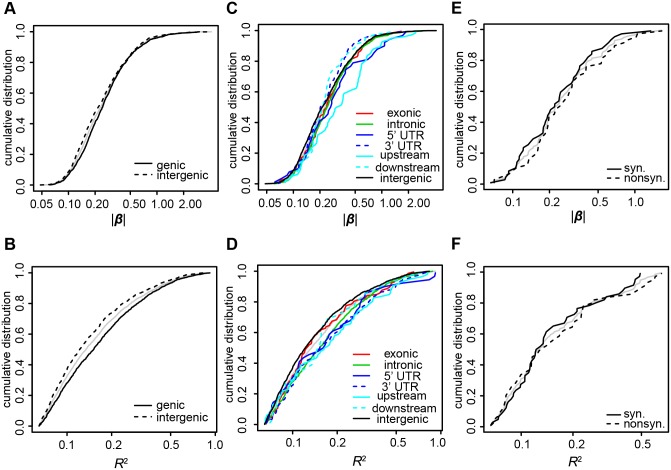
Cumulative curves of effect magnitudes of cis-eQTLs in gene-structure-based functional categories.Cumulative curves represent the distributions of |β| values or R
2 values of cis-eQTLs in each category. Cumulative distribution of all cis-eQTLs (A–D) or all exonic cis-eQTLs (E–F) are shown in grey. The X axis is a log scale. A, B) Distributions of genic and intergenic cis-eQTLs for |β| values (A) or for R
2 values (B). C, D) Distributions of genic subcategories and intergenics for |β| values (C) or for R
2 values (D). E, F) Distributions of nonsynonymous and synonymous eQTLs for |β| values (E) and for R
2 values (F).